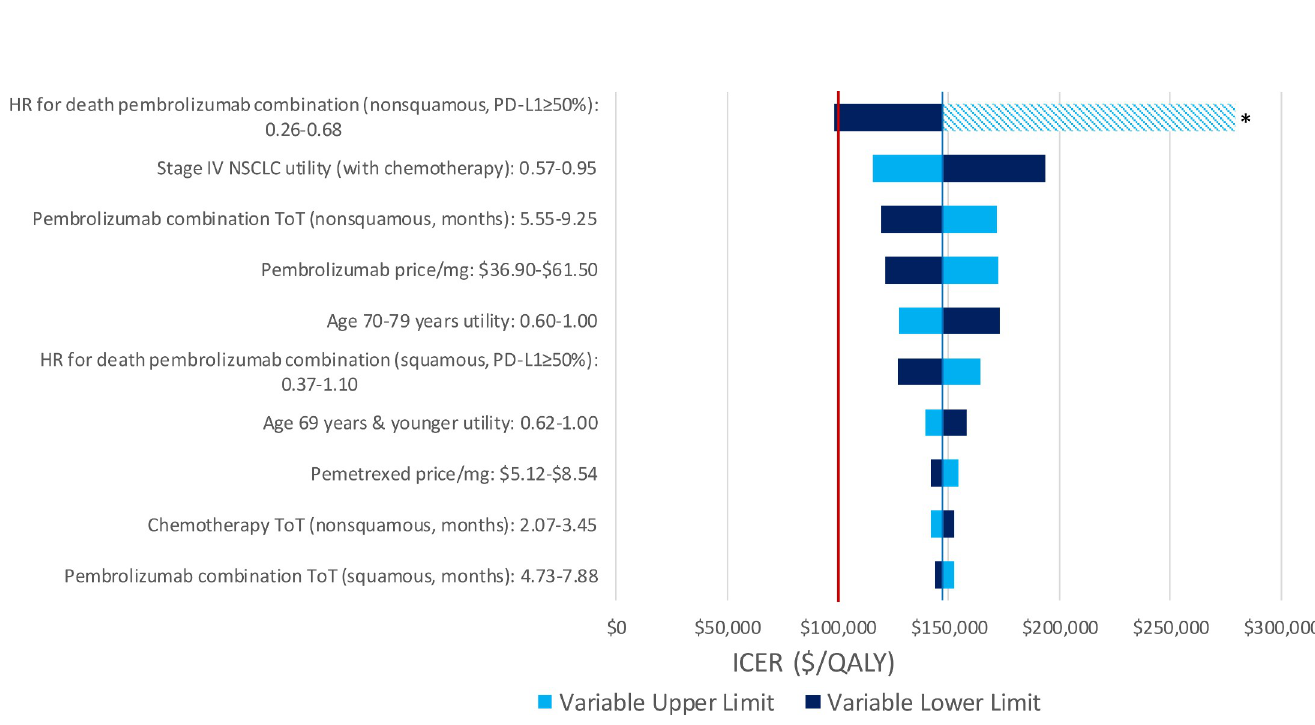
Fig 3. Deterministic sensitivity analysis for the PD-L1-high model—pembrolizumab combination versus chemotherapy. HR, hazard ratio; NSCLC, non-small cell lung cancer; ToT, time on treatment; OS, overall survival � Pembrolizumab combination therapy did not weakly dominate pembrolizumab monotherapy, therefore, the efficient frontier changed order and pembrolizumab combination no longer had an ICER compared to chemotherapy.